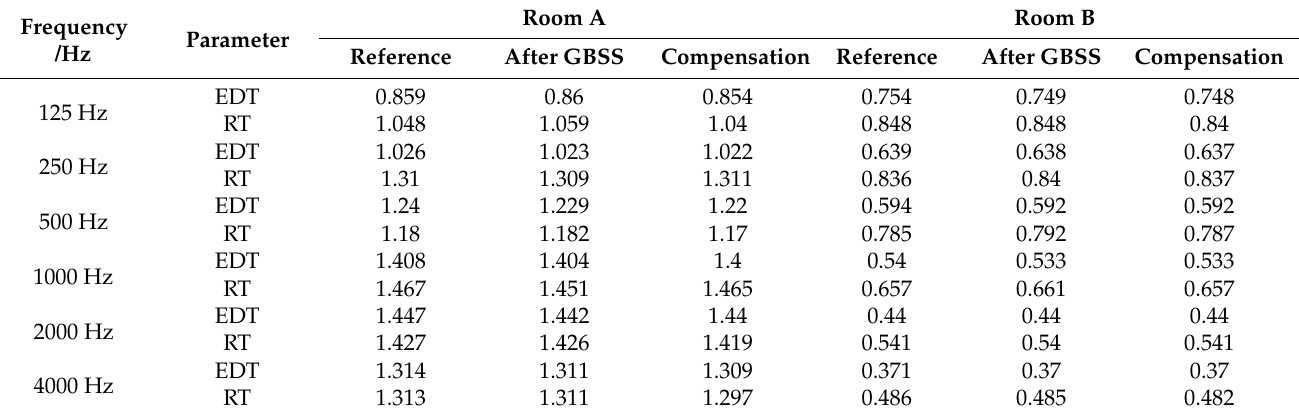
Table 3. Comparison of RTs and EDT between the de-noised RIRs and the compensated RIRs.